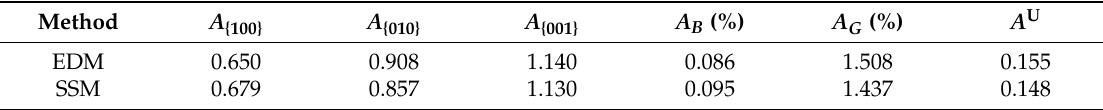
Table 6. The shear anisotropy factors ( A {100} , A {010} , and A {001} ), percent anisotropy factors of bulk ( A B ) and shear ( A G ) moduli, and universal anisotropy factor ( A U ) of B19